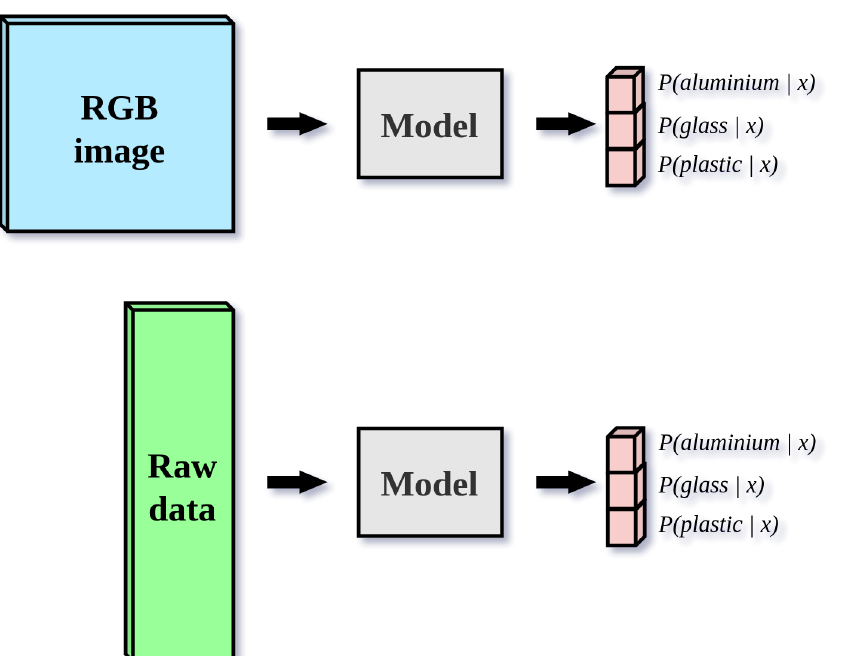
Figure 6. The machine learning setup for all image and raw data models. For image-based classifi- cation, the dimensions of input images are (496, 369, 3). For raw data classification, the dimensions of the input matrix are (1024, 30, 1). All models produce three posterior probability distributions P ( Y i = 1 | x ) , where i ∈ { aluminium , glass , plastic }